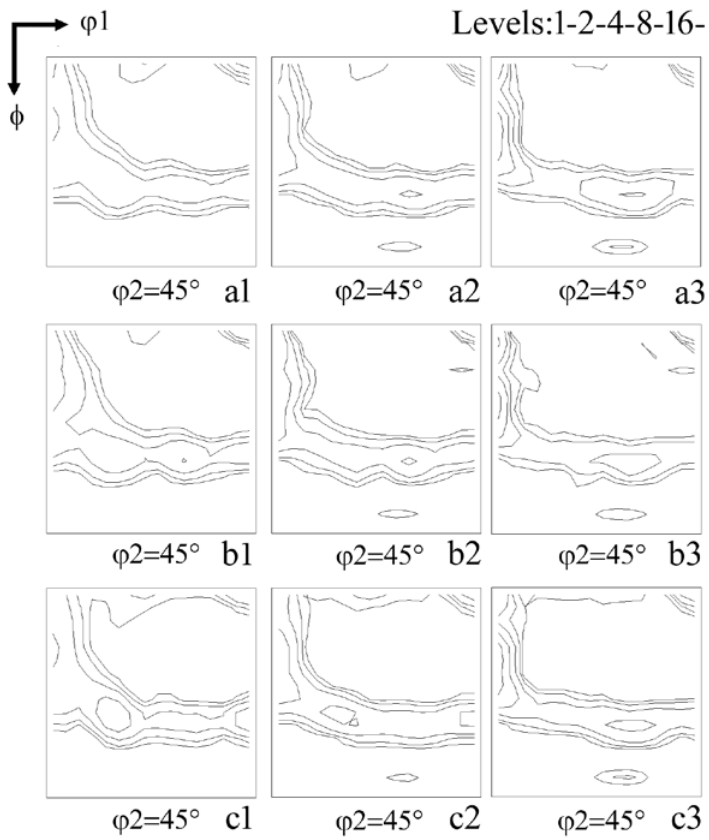
Figure 5. The calculated rolling deformation textures under different strains when using α 12 = 0.2, α 13 = 0.04, α 22 = 0.04 while different α 23 and CRSS {110}<111> /CRSS {112}<111> values. α 23 = 0, CRSS {110}<111> /CRSS {112}<111> = 0.95: ( a1 ) ε 33 = − 0.69, ( a2 ) ε 33 = − 1.1, ( a3 ) ε 33 = − 1.6; α 23 = 0, CRSS {110}<111> /CRSS {112}<111> = 1: ( b1 ) ε 33 = − 0.69, ( b2 ) ε 33 = − 1.1, ( b3 ) ε 33 = − 1.6; α 23 = 0.04, CRSS {110}<111> /CRSS {112}<111> = 0.95: ( c1 ) ε 33 = − 0.69, ( c2 ) ε 33 = − 1.1, ( c3 ) ε 33 = − 1.6.